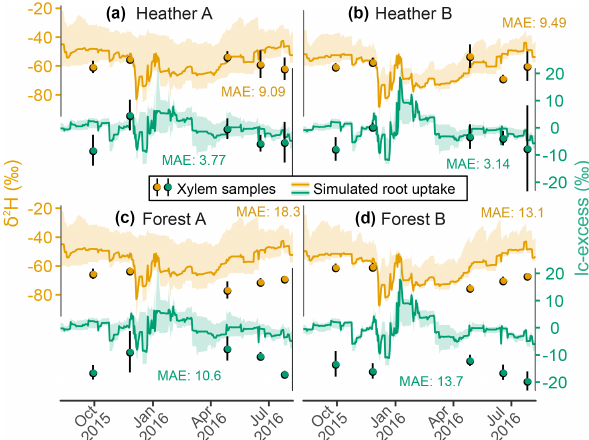
Figure 5. Time series of deuterium composition (orange) and lc- excess (green) in the xylem of two heather shrublands (Heather sites A and B) and two Scots pine stands (Forest sites A and B). Measurements are shown with symbols with one standard devia- tion across replicas, while solid lines display ensemble medians and 90% intervals of simulations, and the corresponding median model–data MAE values are shown.